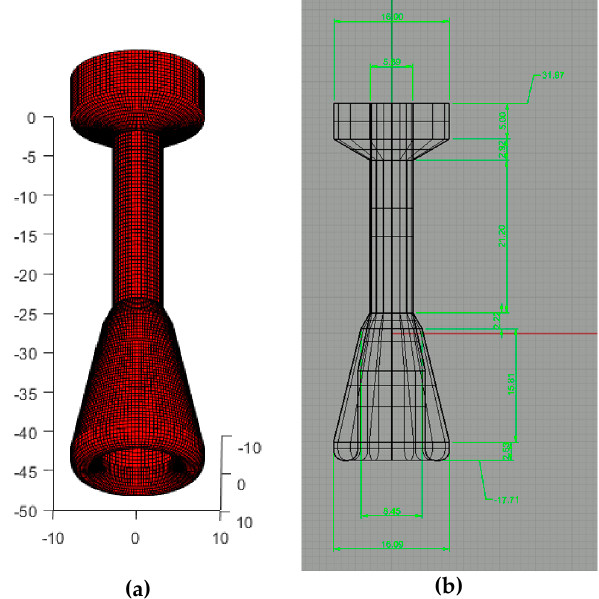
Figure 4. Mesh representation of the boundary element method (BEM) model for the FWEC spar platform submerged part ( a ) and its main dimensions [m] with the reference at its CoG ( b ). Reproduced from [11] (Renewable Energy 44 (2012) 328–339), corresponding to model ‘K’.